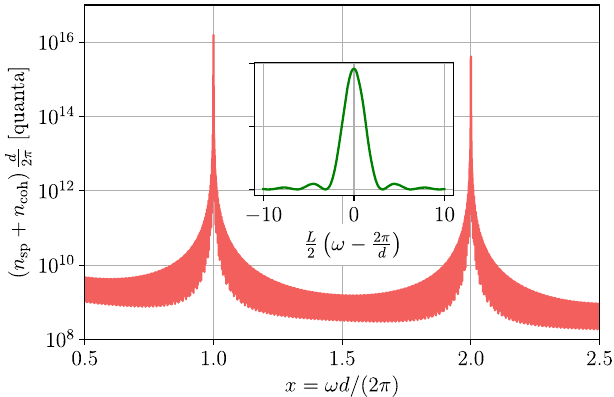
FIG. 3. The incoherent and two harmonics of the coherent pseudophotons spectral densities. The inset demonstrates the zoomed-in peak